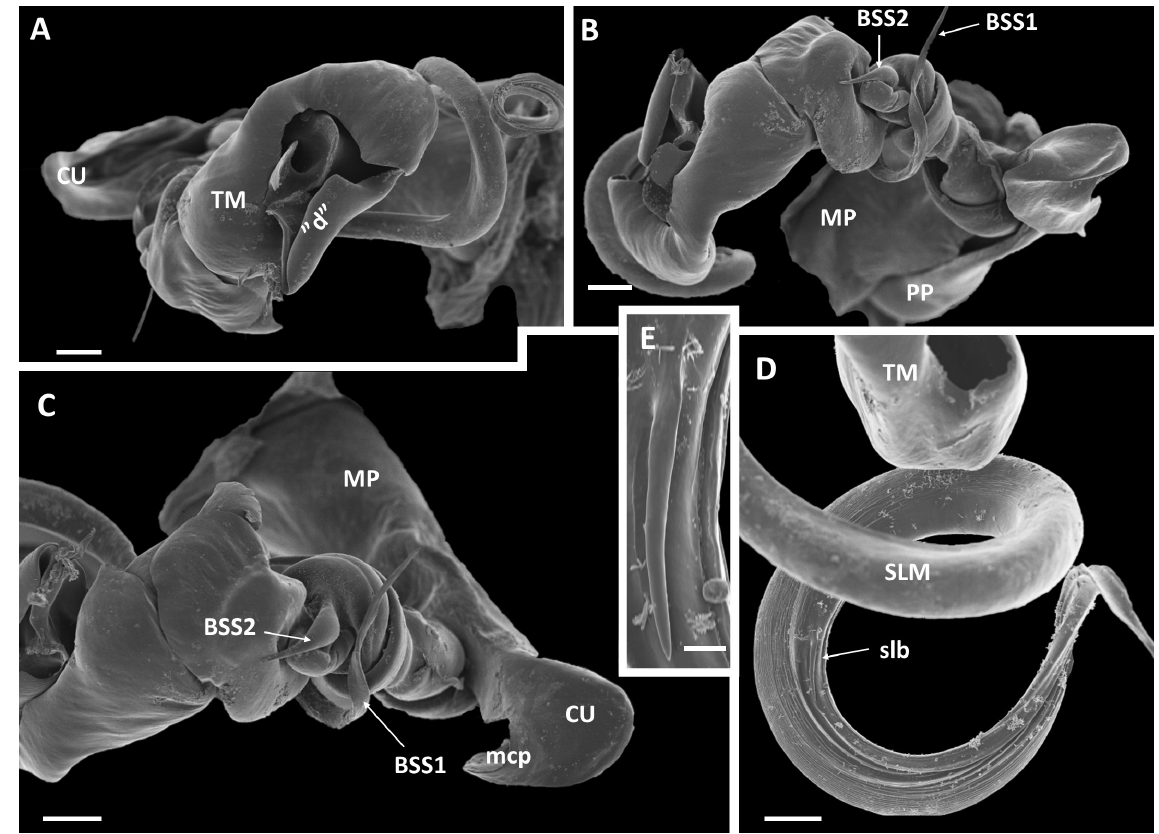
Fig. 59. Syndesmogenus voiensis (Ribaut, 1907), specimen from E Usambara Mts (NHMD 621763), right gonopod. A . Mesal view. B. Subdistal (subventral) view. C . Distomesal view. D . Tips